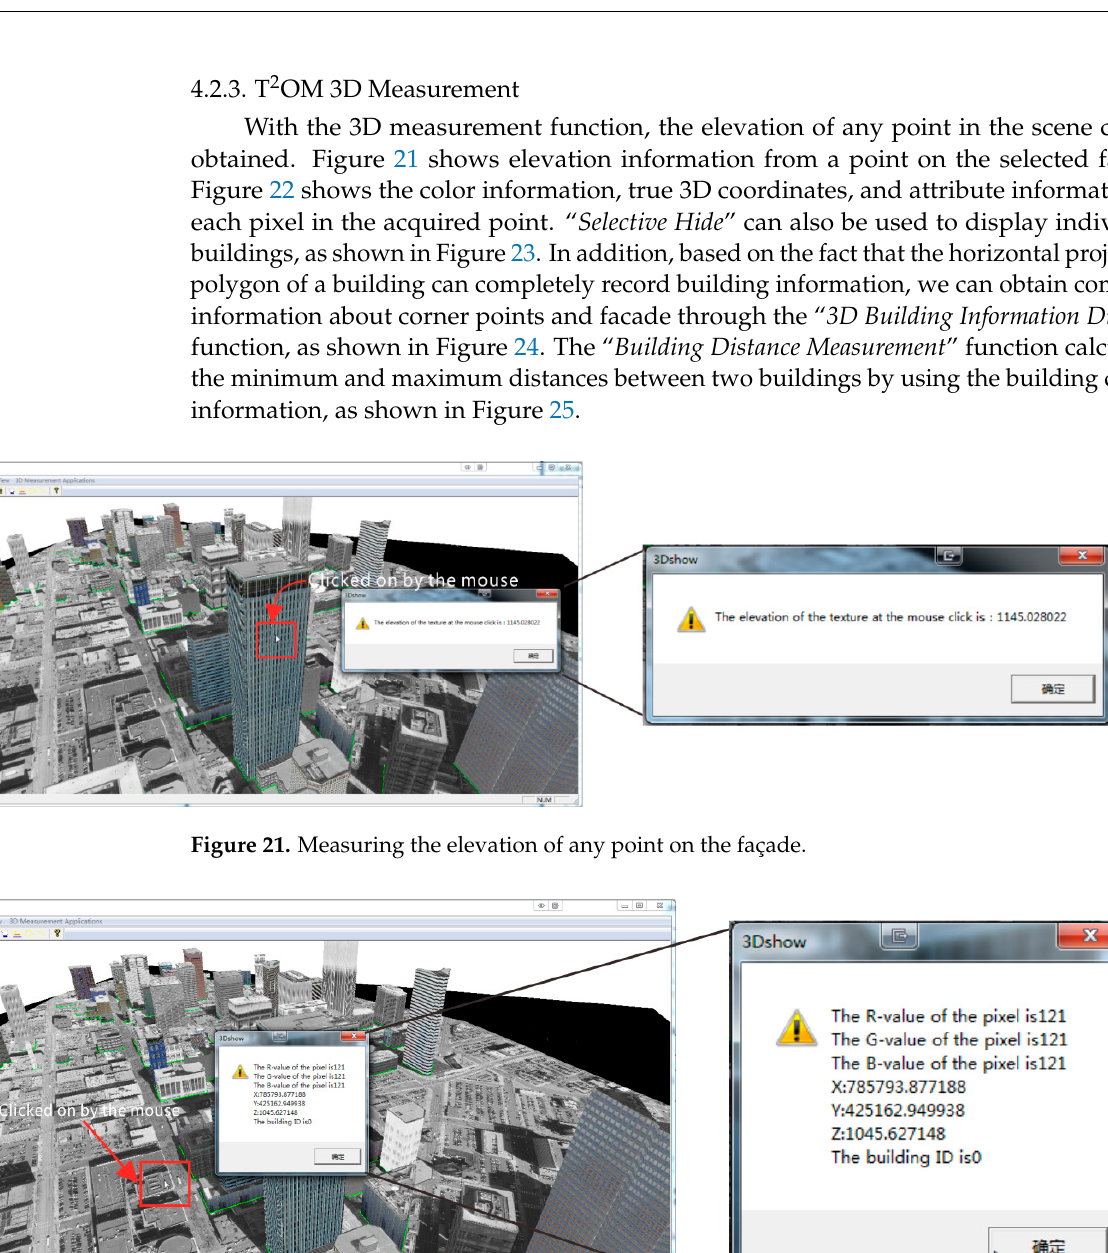
Figure 20. Merging DTM- and DBM-based T 2 Oms on dataset 2; ( a – d ) are an enlarged windows of the four regions.